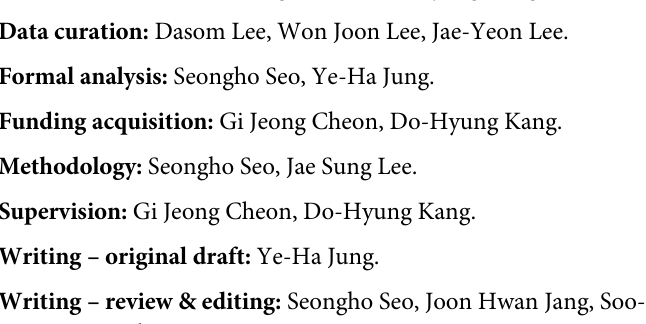
S1 Table. CNS medication for patients’